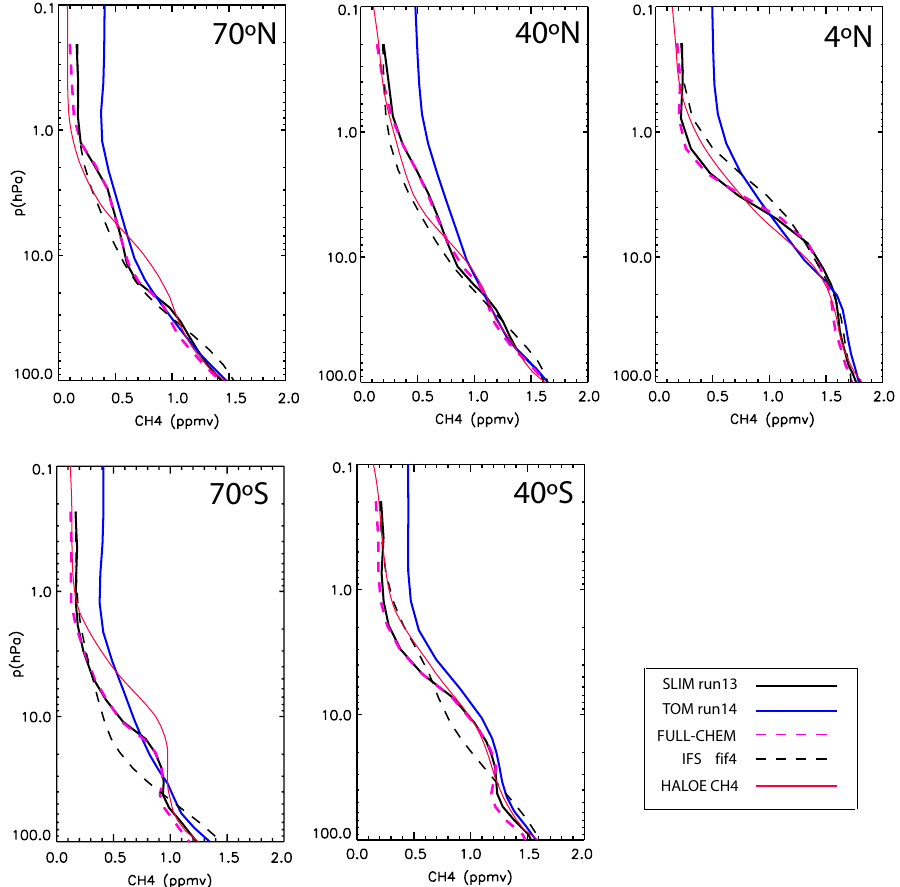
Fig. 6. Annually averaged CH 4 distributions (ppmv) for year 2000 from the CoMeCAT scheme in SLIMCAT run13 (solid black line), TOMCAT run14 (blue line) and in the ECMWF GCM (dashed black line) run fif4 (Table 2) for the latitudes 70 ◦ N, 40 ◦ N, 4 ◦ N, 70 ◦ S and 40 ◦ S (as labelled). HALOE observations have also been included (red line), as well as the CTM full-chemistry run323 (red dashed